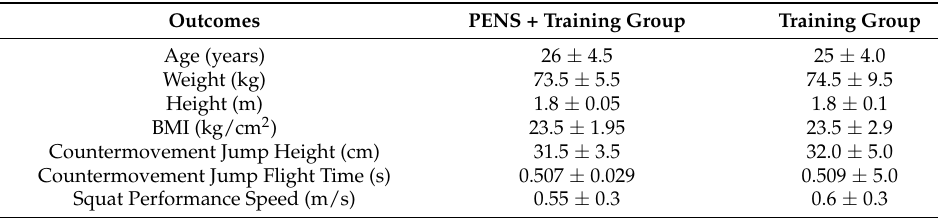
Table 1. Participants’ characteristics at